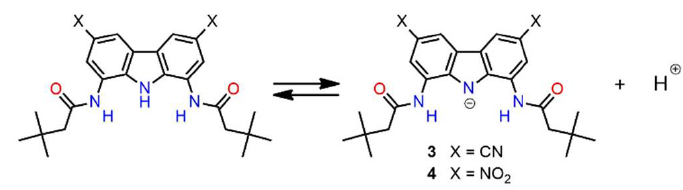
Scheme 5. Self-ionization of receptors 3 and 4